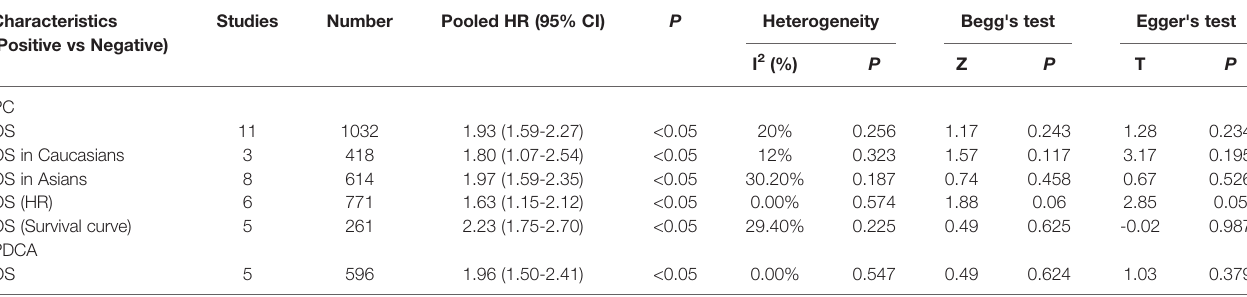
TABLE 3 | Meta-analysis result of pooled HR for overall survival in pancreatic cancer patients. Characteristics (Positive vs Negative)